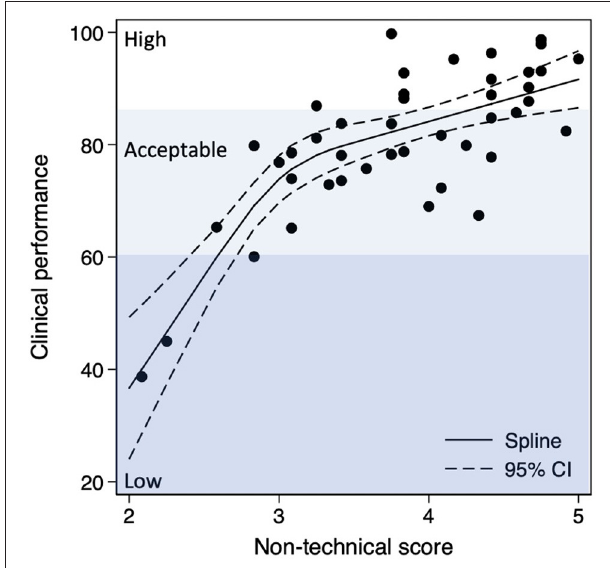
FIGURE 1 | Non-technical score and clinical performance is visualized by spline regression analysis.